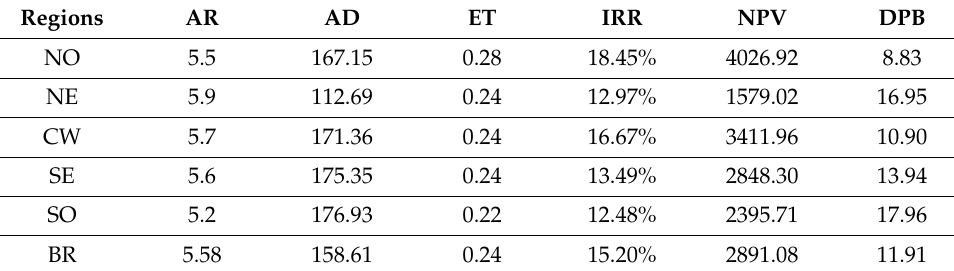
Table 3. Deterministic results after the change proposed by